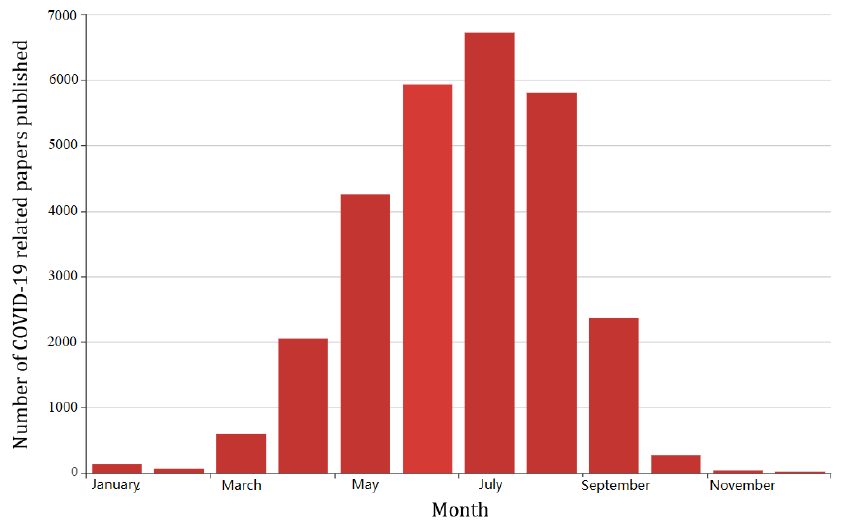
Figure 1. Number of COVID-19-related papers published monthly from the beginning of January to September 27 in